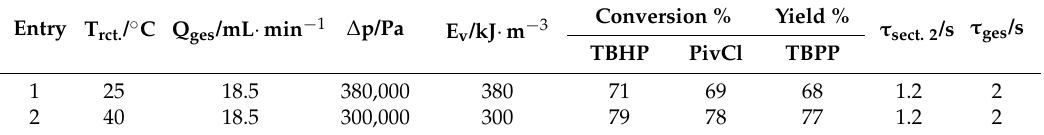
Table 3. Energy density at a total flow rate of 18.5 mL ¨ min ´ 1 by using the OMR for TBPP synthesis at different reaction